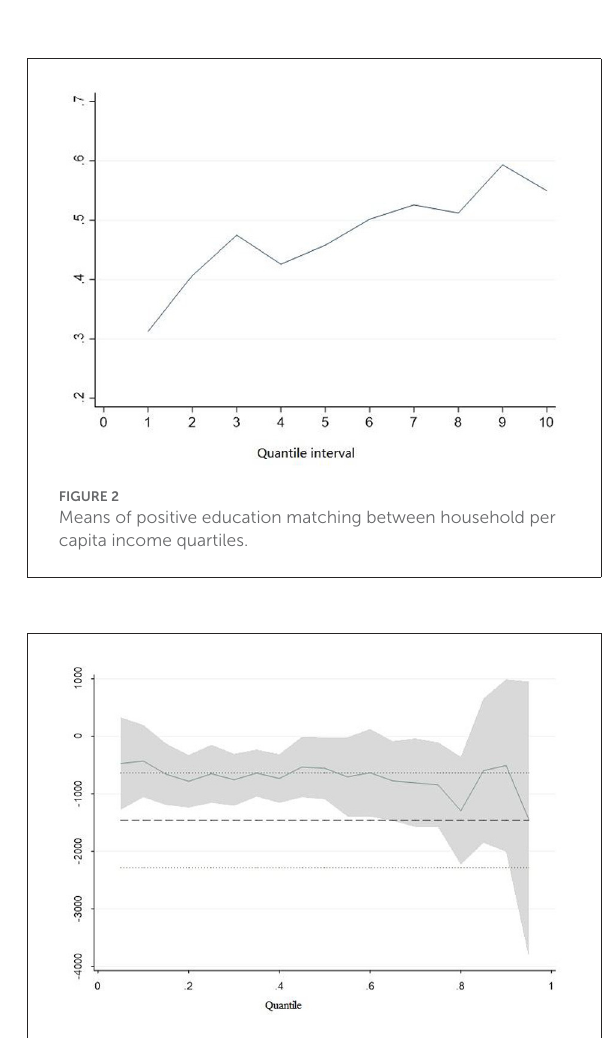
FIGURE3 Marginal contribution rate of spouse education gap at different income